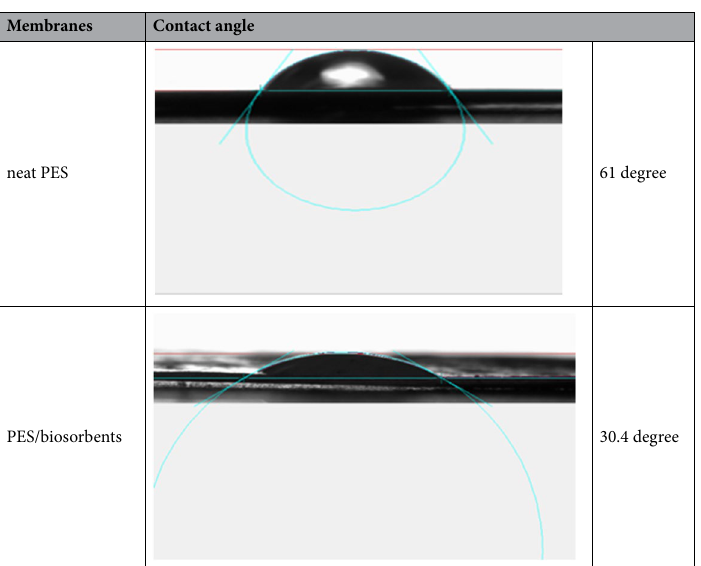
Table 5. Contact angle of naet PES and